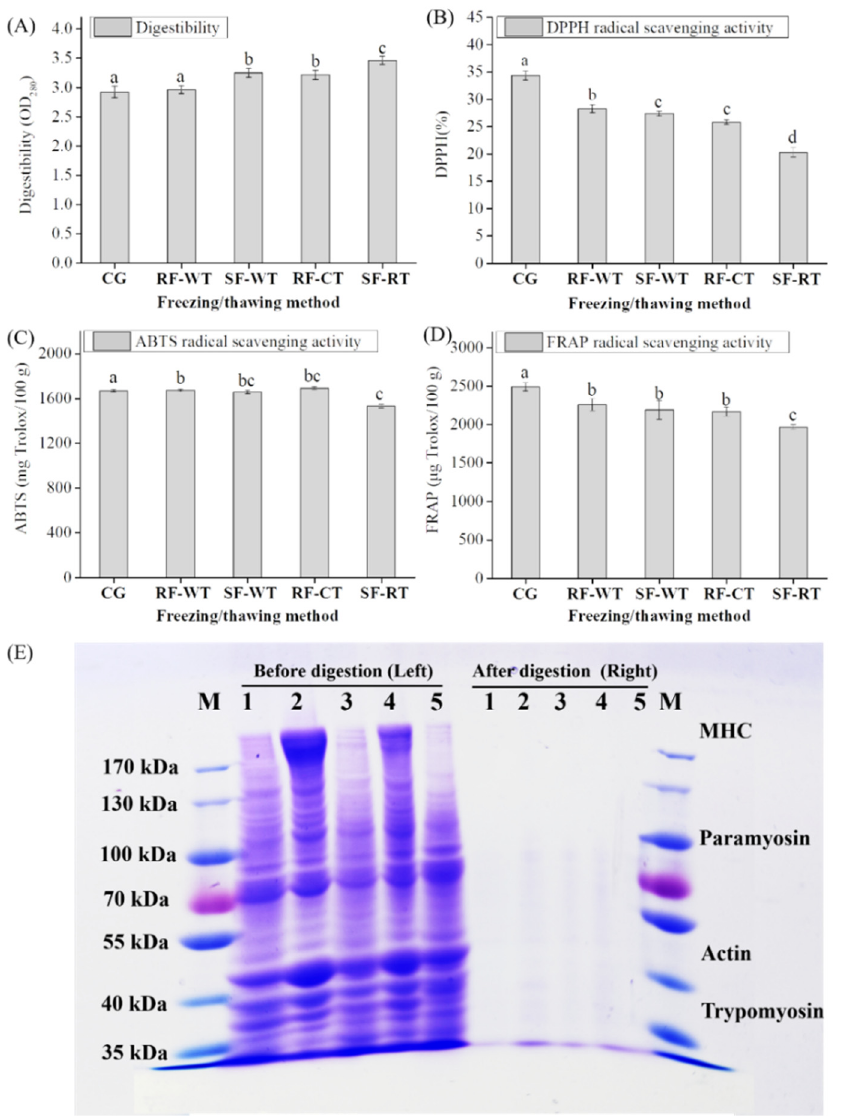
Figure 6. Digestibility ( A ), antioxidant activities ( B – D ), and proteins profiles ( E ) of meat gels from crayfish subjected to different freezing-thawing methods. Different letters (a–d) indicate significant differences ( p < 0.05). Samples were prepared before (Left) and after (Right) digestion. M, marker; 1, CG; 2, RF-WT; 3, RF-CT; 4, SF-WT; 5, SF-CT. MHC, myosin heavy chain. CG, control group; RF, liquid nitrogen rapid freezing; SF, refrigerator slow freezing; CT, cold thawing; WT, water immersing